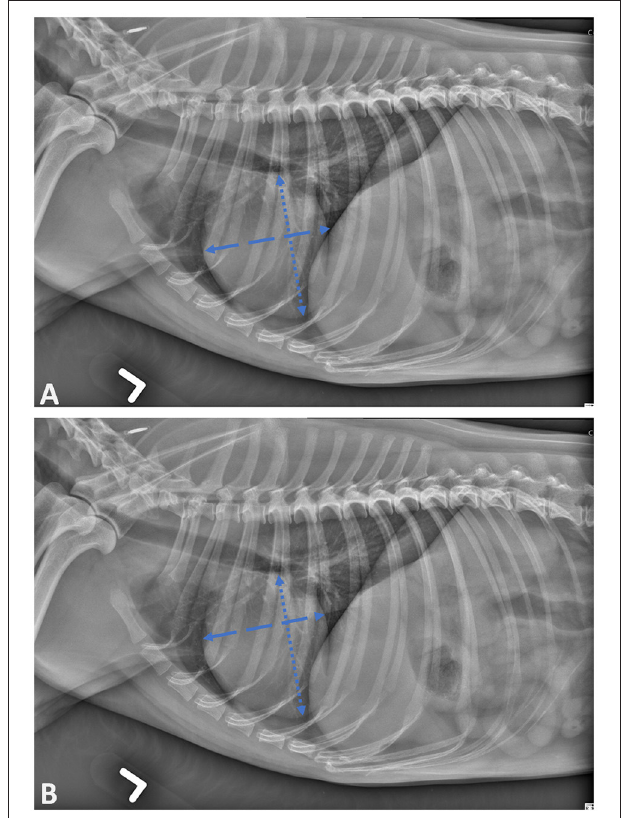
FIGURE 1 | Lateral projection of skeletally mature canine patient demonstrating the cardiac landmarks for vertebral heart scale (VHS) measurements as described by Buchanan (A) and Poad (B)